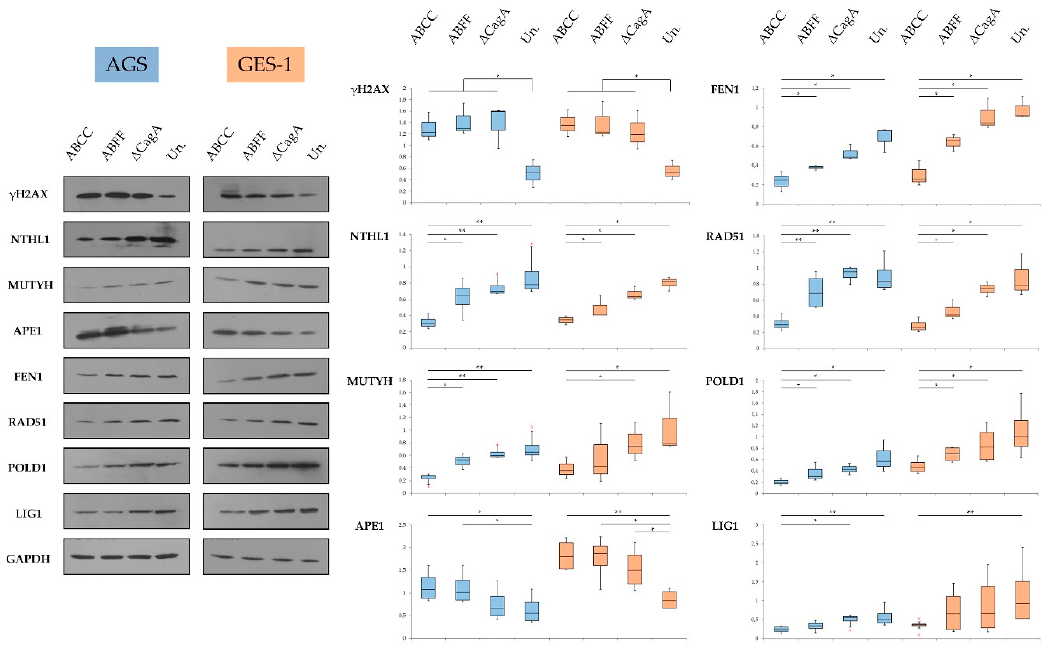
Figure 7. Expression of DNA damage repair components in H. pylori -infected AGS (blue) and GES-1 (orange) cells. Results suggest CagA-independent increase of Ser139 phosphorylated histone H2AX ( γ H2AX) and decrease of Nth Like DNA Glycosylase 1 (NTHL1), MutY DNA Glycosylase (MUTYH), Flap Structure-Specific Endonuclease 1 (FEN1), RAD51 Recombinase, DNA Polymerase Delta Catalytic Subunit (POLD1), and DNA Ligase 1 (LIG1) protein levels, related to the expression and phosphorylation of CagA. Apurinic / Apyrimidinic Endodeoxyribonuclease 1 (APE1) protein levels were increased during the infection in a CagA-related manner. Quantification of protein levels was conducted by densitometry in at least three experimental replicates per condition. Statistical analysis was performed using Mann–Whitney U test (levels of significance: + p = 0.1–0.05, * p = 0.05–0.01, ** p < 0.01); Un.: uninfected control.